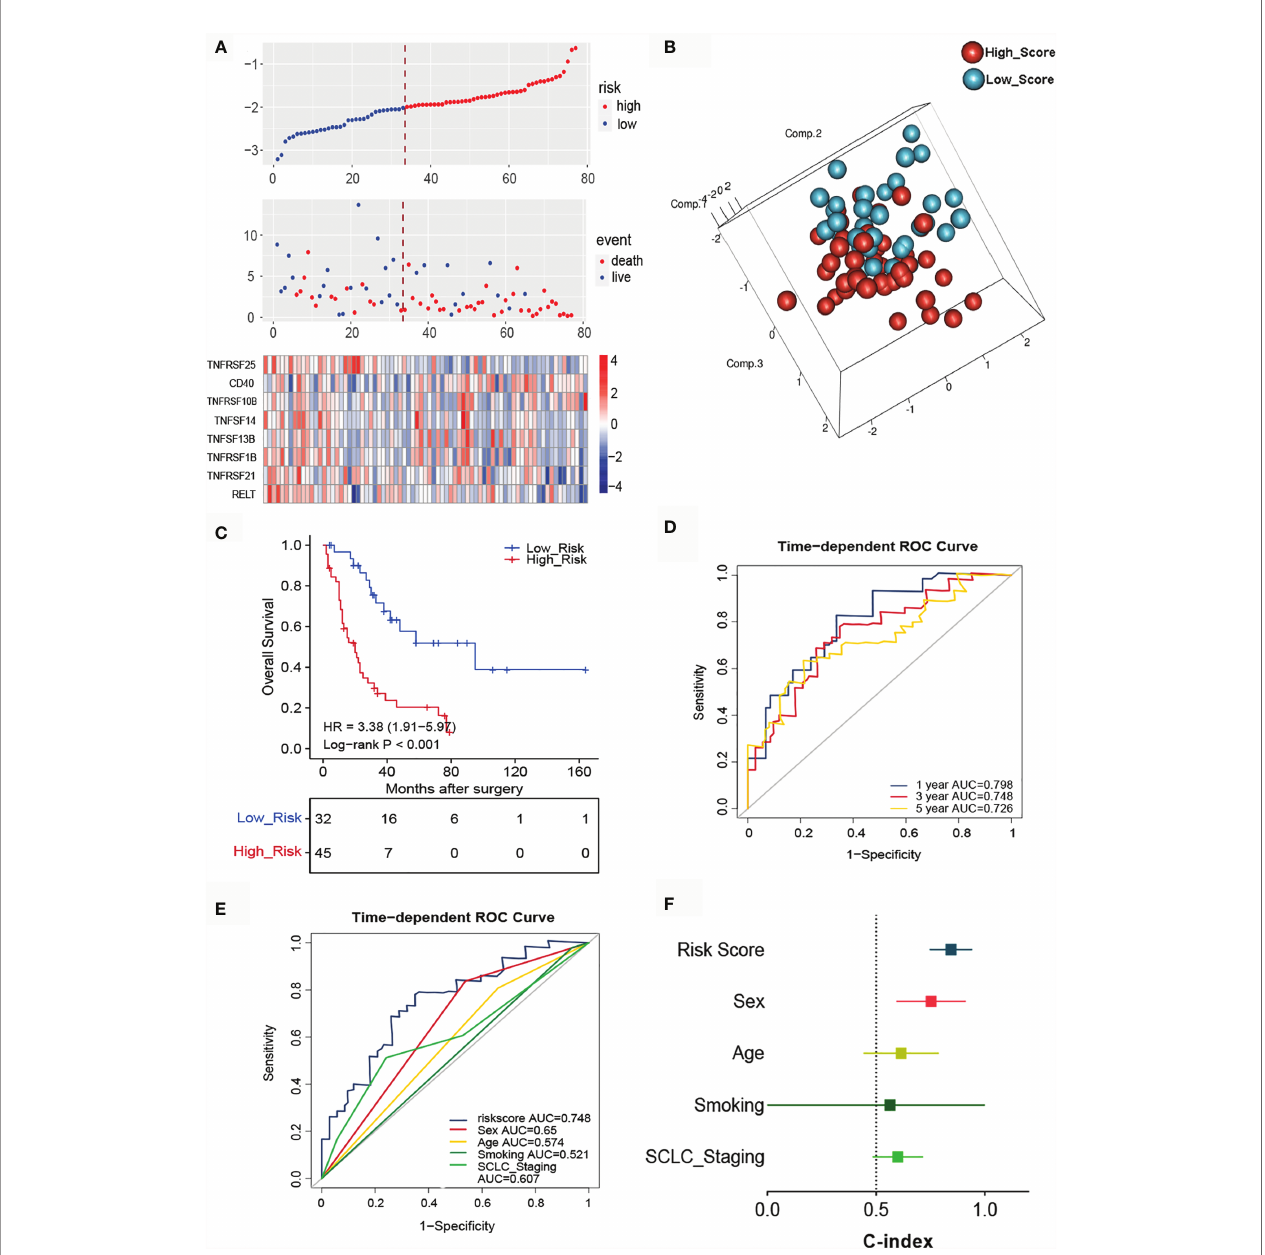
FIGURE 3 | Identi fi cation of the TNF family-based signature in SCLCs from the training cohort. (A) The distribution of risk score, survival status, and TNF family gene expression pro fi les. (B) PCA of patients with SCLC based on the expression levels of the eight selected genes. (C) The Kaplan-Meier curve of OS for patients with SCLC based on the risk score. (D) Time-dependent ROC curves of the risk score for 1-, 3-, and 5-year OS prediction for the training cohort. (E) ROC analysis for prediction of 3-year survival compared with other clinicopathological factors. (F) C-indexes of models based on the risk score and other clinicopathological